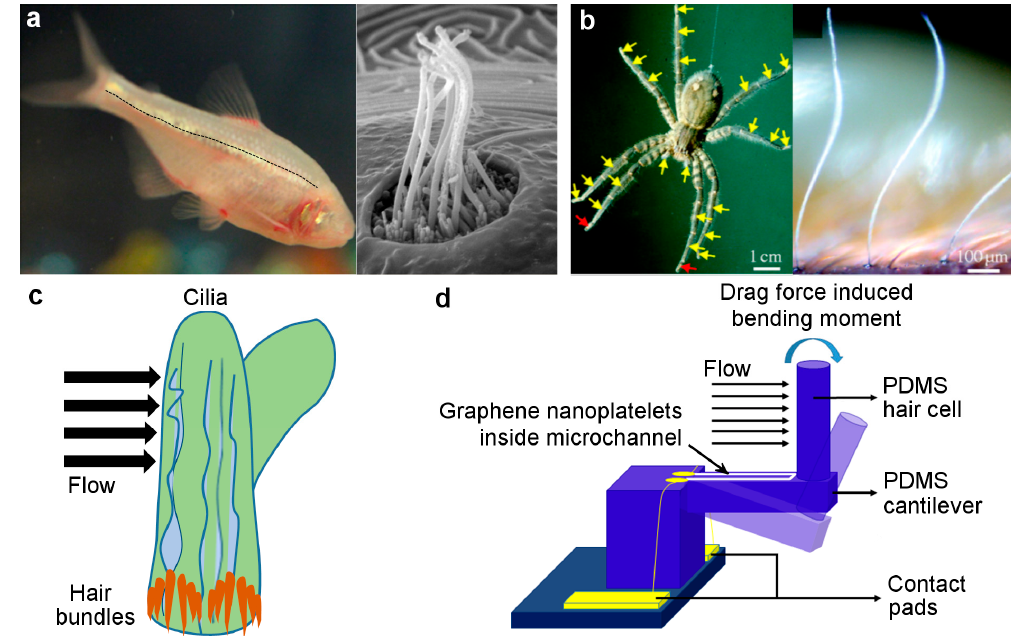
Figure 1. Biomimetic flow sensing: ( a ) lateral line sensors on fish skin (shown by black dotted line) containing hair-like cilia bundles (credit: Prof. Andrew Forge [20]) for water flow sensing; ( b ) hair-like sensilla on spider legs (reprinted with permission from [14], Copyright The Royal Society, 2008); ( c ) schematic of flow-induced bending of cilia bundles encapsulated by a protective cupula; and ( d ) sensing principle of bioinspired sensor comprising hair cell and cantilever used in this work.